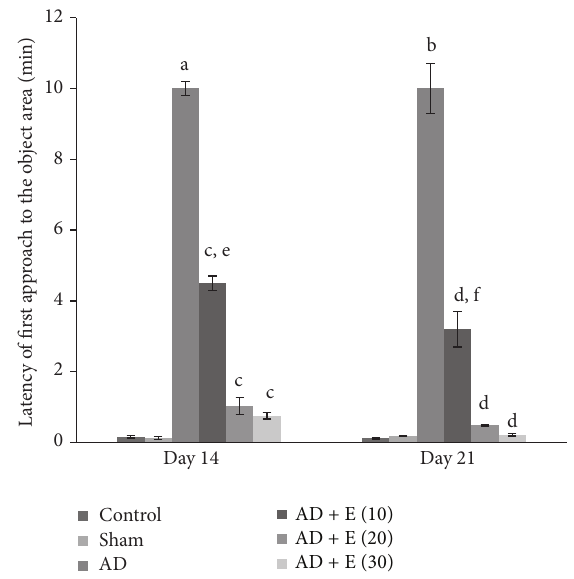
Figure 4: The latency of first approach to the object area in an elevated open space with a novel object (for anxiety status) of different experimental groups of rats. a cAD versus control/sham operated rats at day 14 ( 𝑝 < 0.001 ), b cAD versus control/sham operated rats at day 21 ( 𝑝 < 0.001 ), c cAD versus etoricoxib treated cAD at all the doses at day 14 ( 𝑝 < 0.001 ), d cAD versus etoricoxib treated cAD at all the doses at day 21 ( 𝑝 < 0.001 ), e 10 mg/kg body weight etoricoxib administered cAD versus 20, 30 mg/kg body weight etoricoxib administered cAD at day 14 ( 𝑝 < 0.001 ), and f 10 mg/kg body weight etoricoxib administered cAD versus 20, 30 mg/kg body weight etoricoxib administered cAD at day 21 ( 𝑝 < 0.001 ). Abbreviations are the same as in Figure 1. Values are expressed in mean ± SEM ( 𝑛 = 6 in each